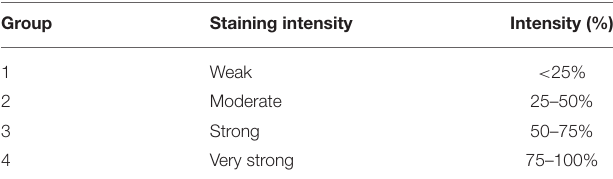
TABLE 3 | Classification: immunostaining degree